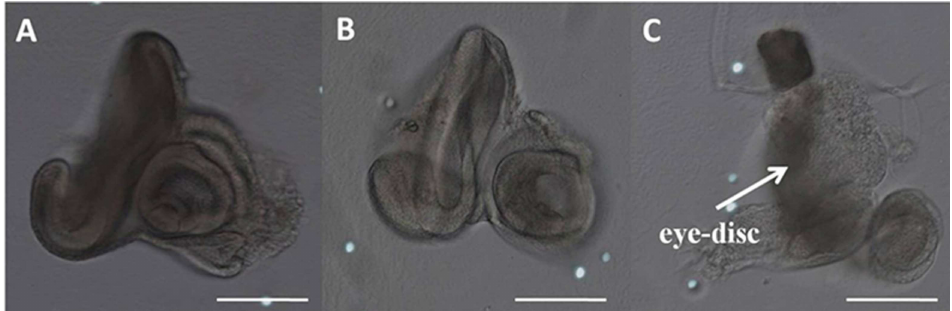
Fig 5. Third instar eye-antenna discs. (A): y w (B): UAS-RpPax6 (C): UAS-RpPax6/ey-GAL4 flies. The boxedareas show growth defects in the eye disc of UAS-RpPax6/ey-GAL4 larvae. Scale bars = 100 μ